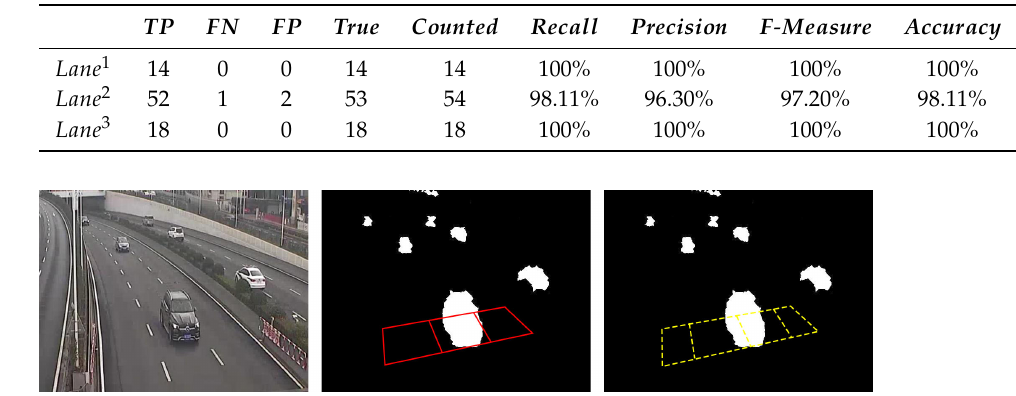
Figure 20. Example of the experimental results in Video VI. Table 15. Experimental results of each